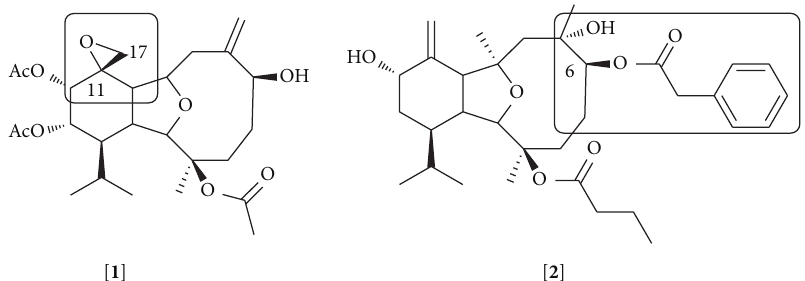
Figure 1: Structures of klymollin G [ 1 ] and klymollin M [ 2 ]. The epoxy group at C-17 for klymollin G and phenylacetate group at C-6 are labeled.